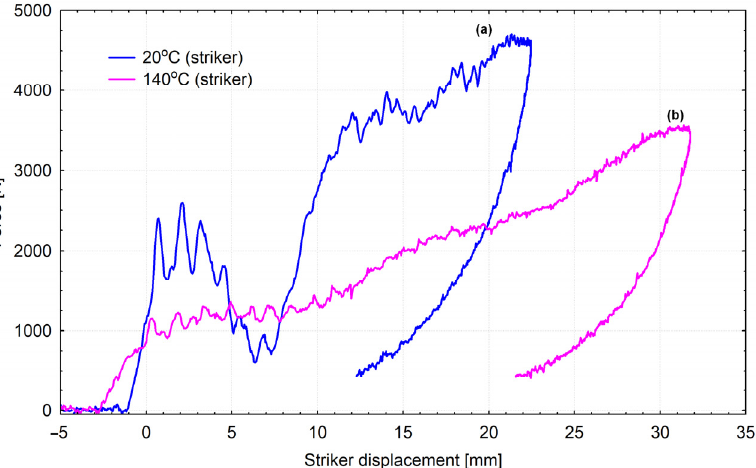
Figure 10. Experimental characteristics of force in the function of an impactor movement depending on thermal shock: ( a ) standard temperature value (20 °C), ( b ) extreme temperature value (thermal shock at the temperature of 140 °C for 10 min).